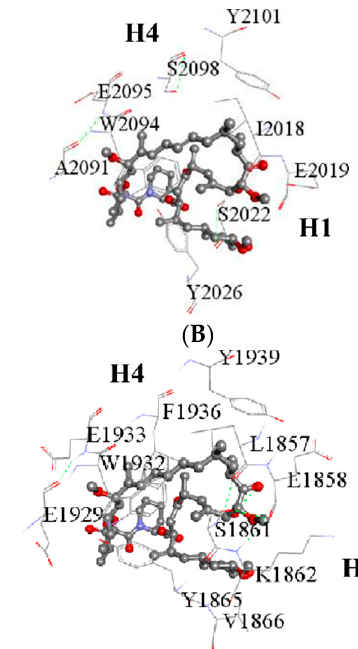
colored boxes: catalytic (red) and activation (green). Similar/identical residues, reference sequences, and top-ruler num- bers are as described in Figure 3.